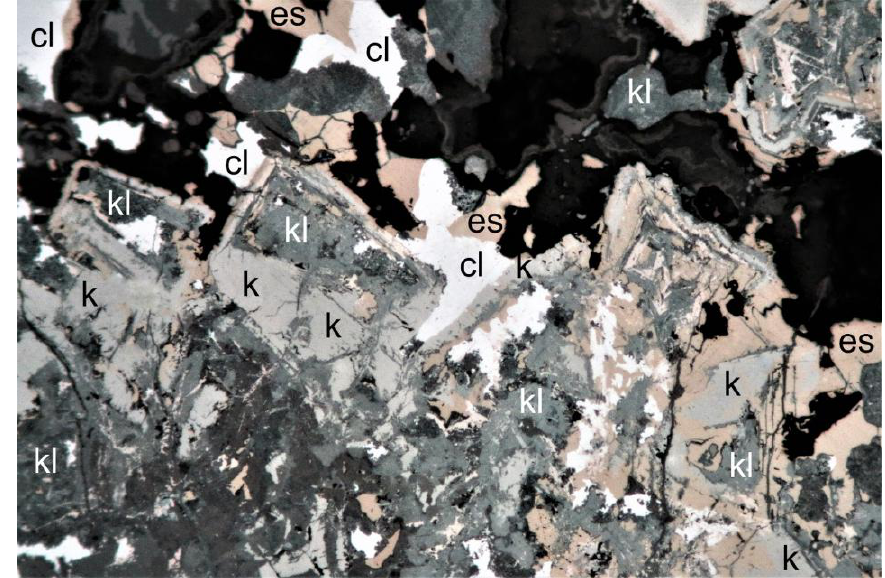
Figure 8. Detail from Se vein Type 3: Few preserved remnants of former subhedral krut’aite-(g1) crystals (k) project into a cavity (black) of the host rock. The originally rectangular shapes of the krut’aite crystals are traced by thin zones of trogtalite-(g1). Patchily distributed replacement and alteration products are klockmannite-(g2) (kl), eskebornite-(g2) (es), and clausthalite-(g2) (cl). Reflected light image, 500-μm-wide, plane polarized light.